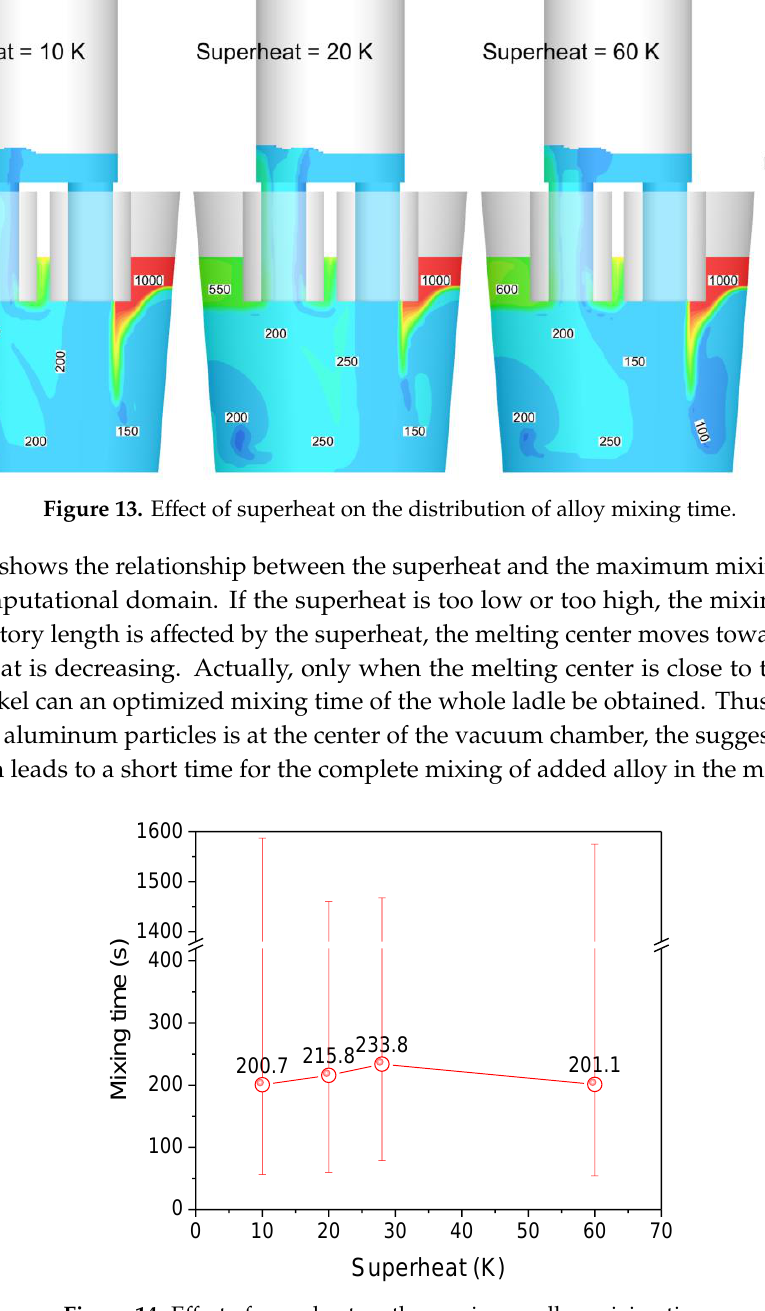
Figure 14. Effect of superheat on the maximum alloy mixing time.